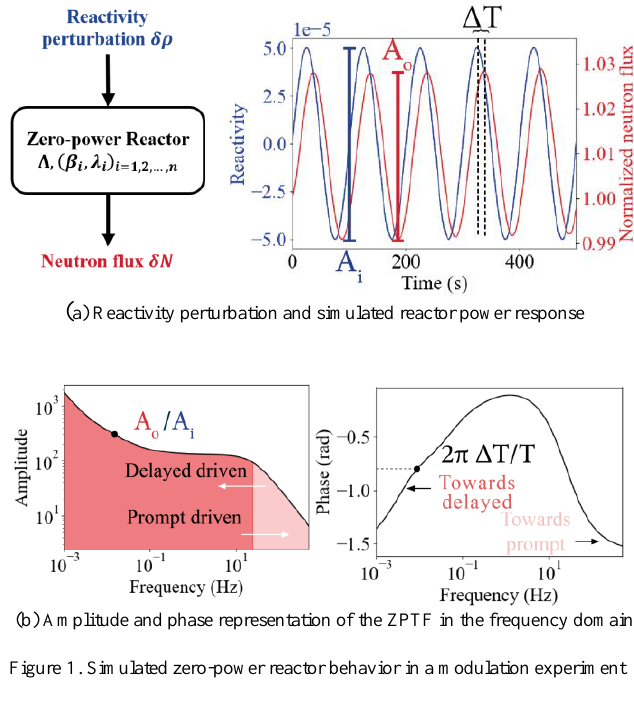
CROCUS is a zero-power research reactor operated at EPFL.